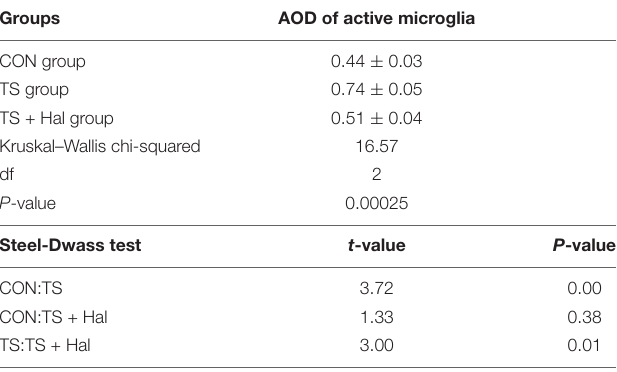
TABLE 3 | Comparison of AOD of active microglia in each